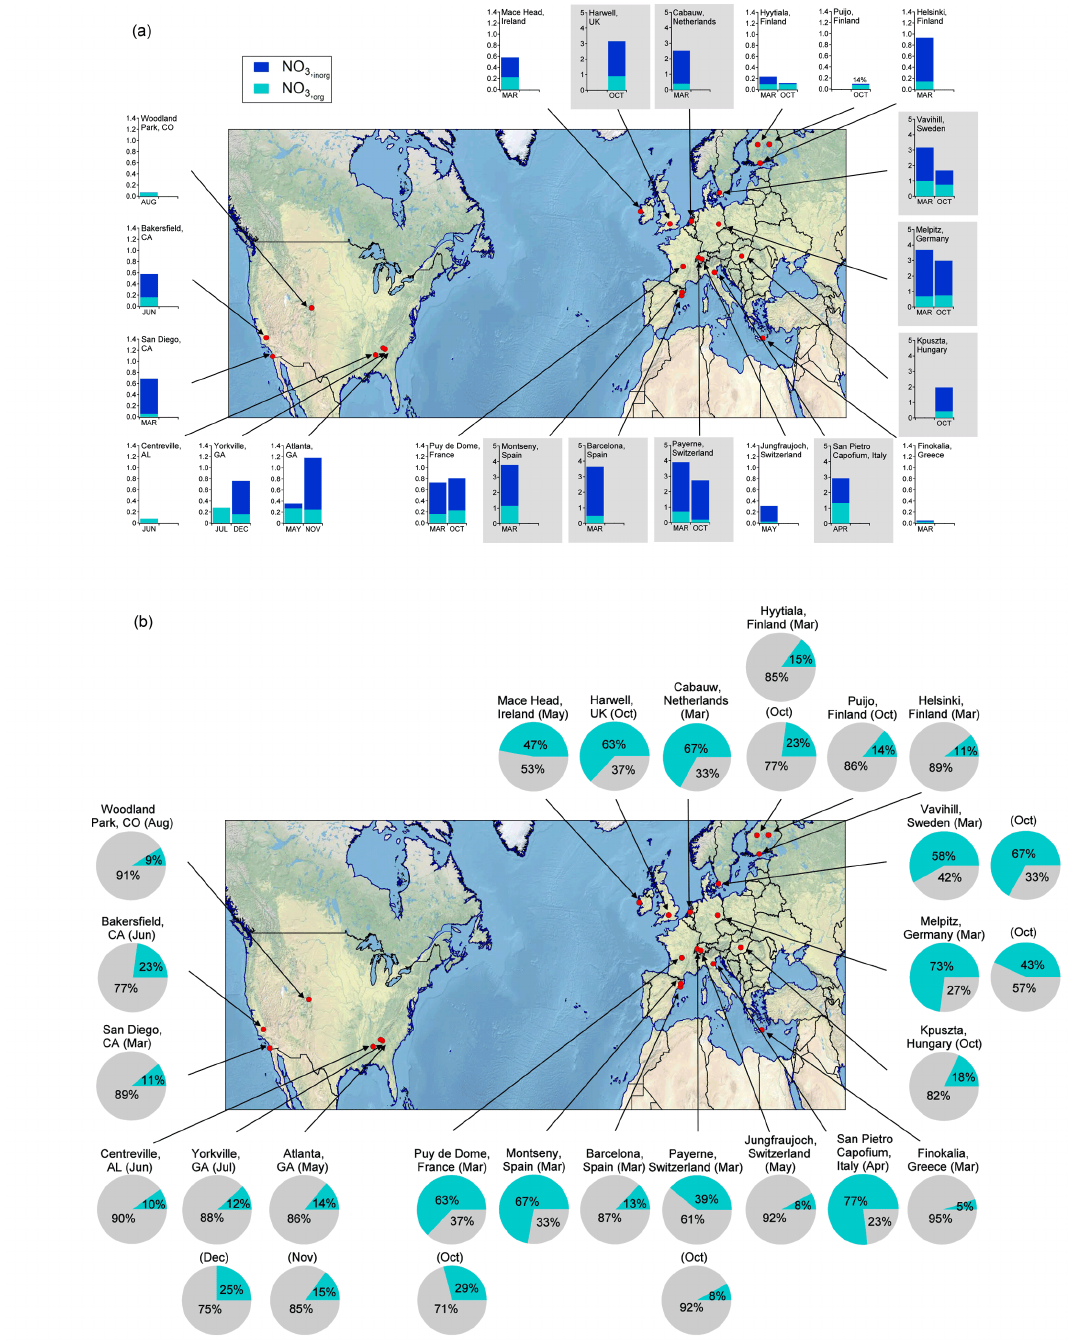
Figure 5. (a) Average mass concentrations (in µgm − 3 , ambient temperature and pressure) of submicrometer particulate organic nitrates (NO 3 , org ) and particulate inorganic nitrates (NO 3 , inorg ) in different months at multiple sites. The concentrations correspond to mass con- centrations of − ONO 2 functionality. Note that the y axis is different for sites with total nitrates greater than 1µgm − 3 (shaded). Detailed information and measurements for each site are provided in Table S5. (b) Percentage (by mass; cyan) of submicrometer particulate organic nitrate aerosols in ambient organic aerosols in different months at multiple sites. Detailed information and measurements for each site are provided in Table